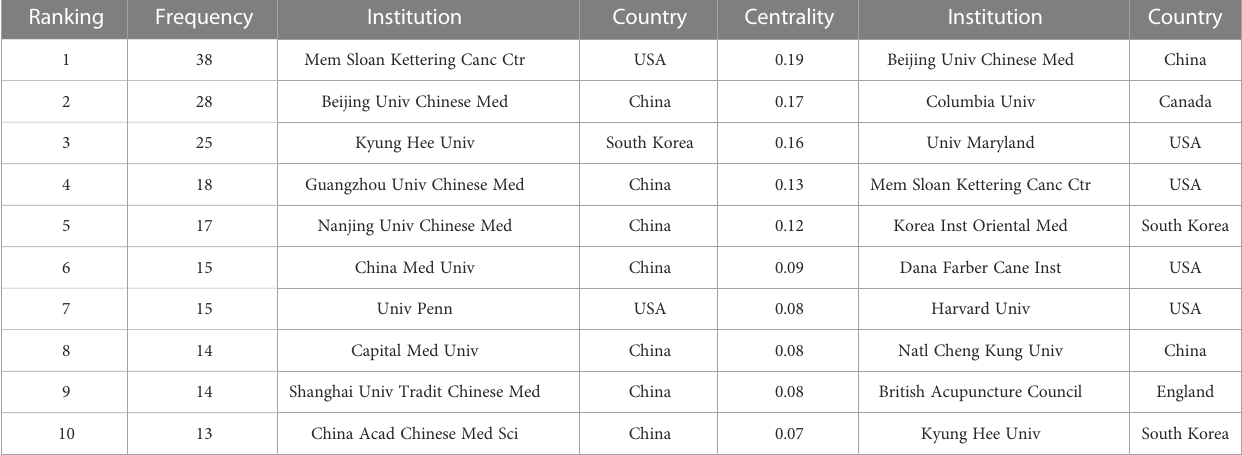
TABLE 3 Top 10 institutions related to the research of acupuncture for cancer pain. Ranking